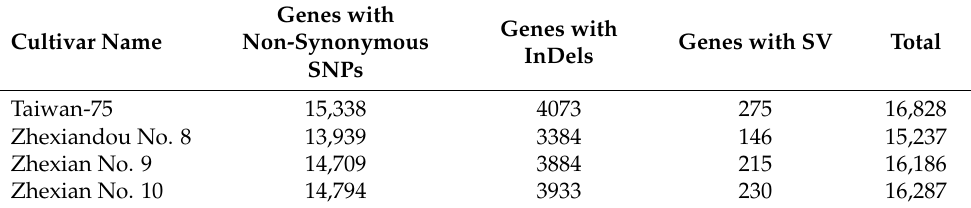
Table 3. The gene numbers of the variations for each